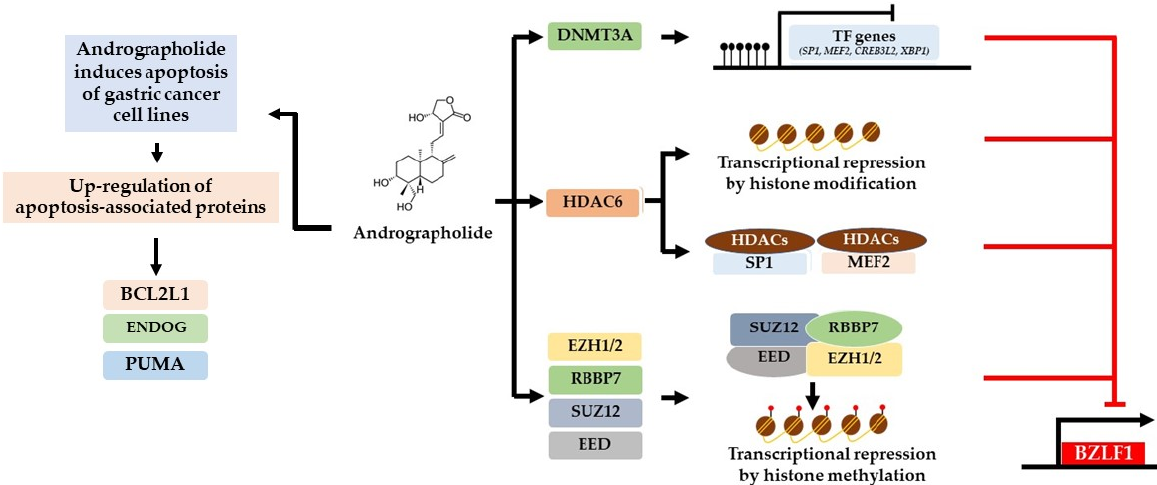
Figure 8. Possible mechanisms of inhibition of EBV lytic reactivation and induction of apoptosis by andrographolide. For the inhibition of lytic reactivation of EBV, there are three possible mechanisms. The first is by inducing the expression of DNA methyltransferases (DNMT3A) that may inhibit the expression of activator proteins (MEF2D, SP1, and others) through DNA methylation that may lead to the suppression of BZLF1. Secondly, andrographolide induces the expression of histone deacetylases, HDAC6. HDAC6 may inhibit the expression of host TFs through histone acetylation or interact directly with host TFs (MEF2D and SP1), interfering with their ability to activate the EBV lytic reactivation. Lastly, andrographolide induces the expression of PRC2-complex proteins (EZH1/2, RBBP7, SUZ12, and EED). These proteins may disrupt the transcriptional activity of EBV. In addition, andrographolide treatment can induce the expression of apoptotic-related proteins, especially protein involved in mitochondria dependent pathways (BCL2L1, EDOG, and PUMA).